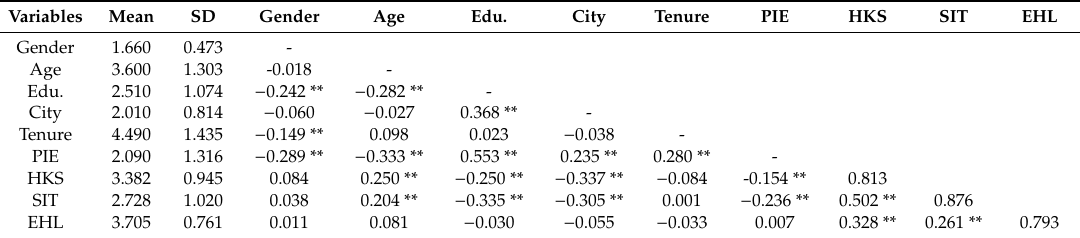
Table 4. Covariance